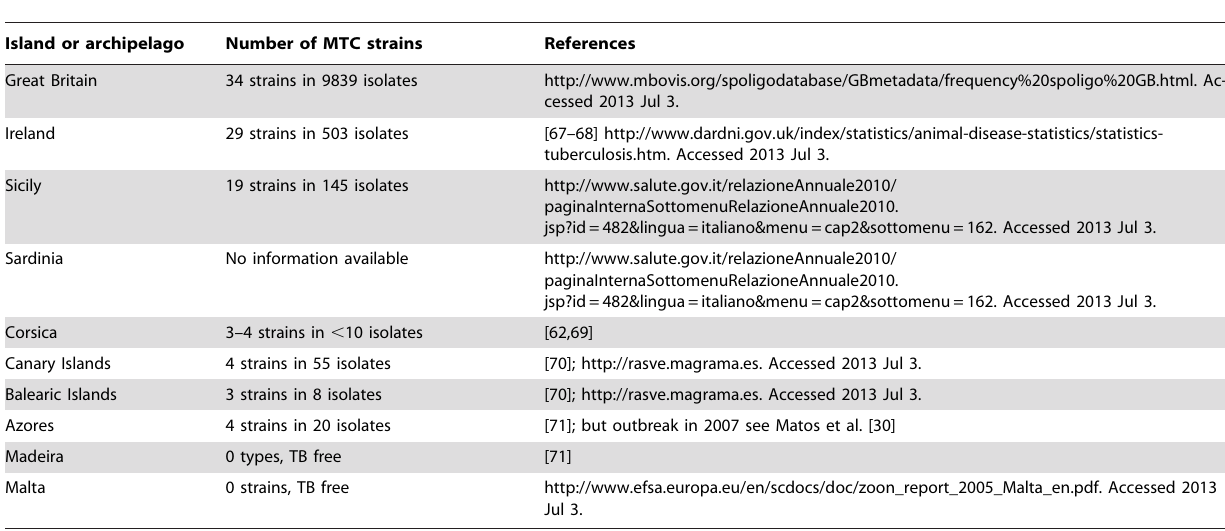
Table 1. Relevant epidemiological characteristics of the ten islands or archipelagos included in the study (see also Fig. 1).